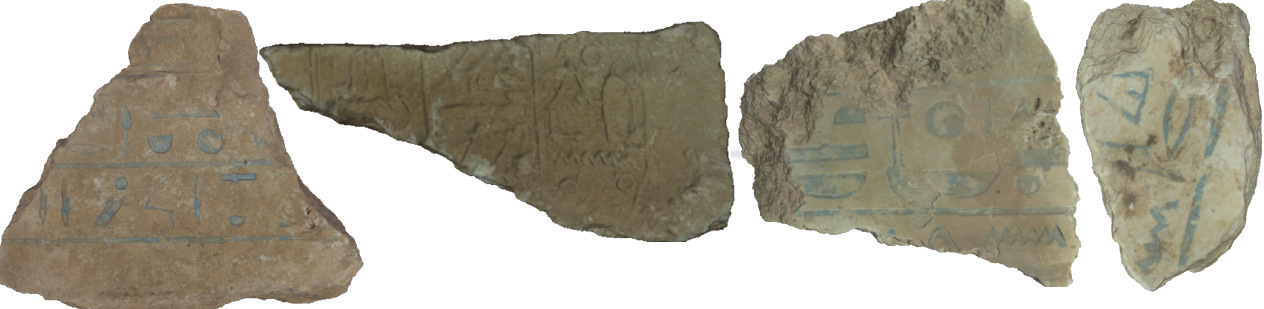
Figure 2. 3D models of ancient Egyptian decorated blocks with sunk relief decorations. In total, 30 fragments of this type are used to develop and test the proposed